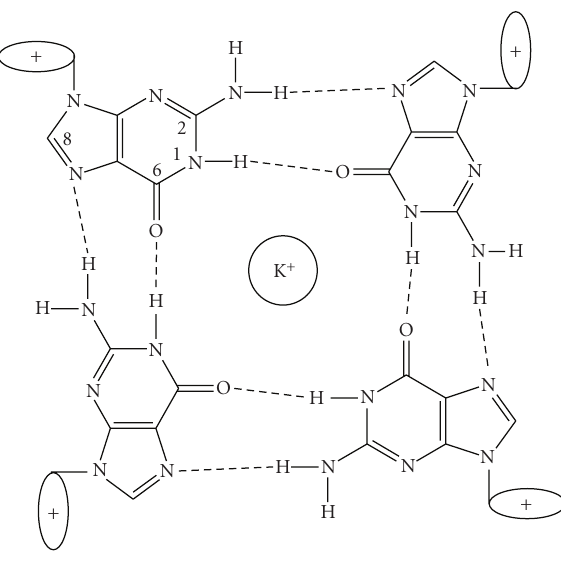
Scheme 1: Schematic representation of the G-quartet.